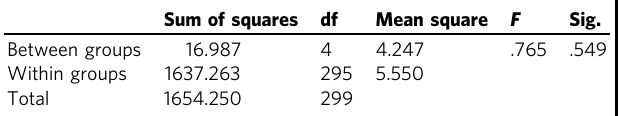
Table 1 Types of statistical tests.